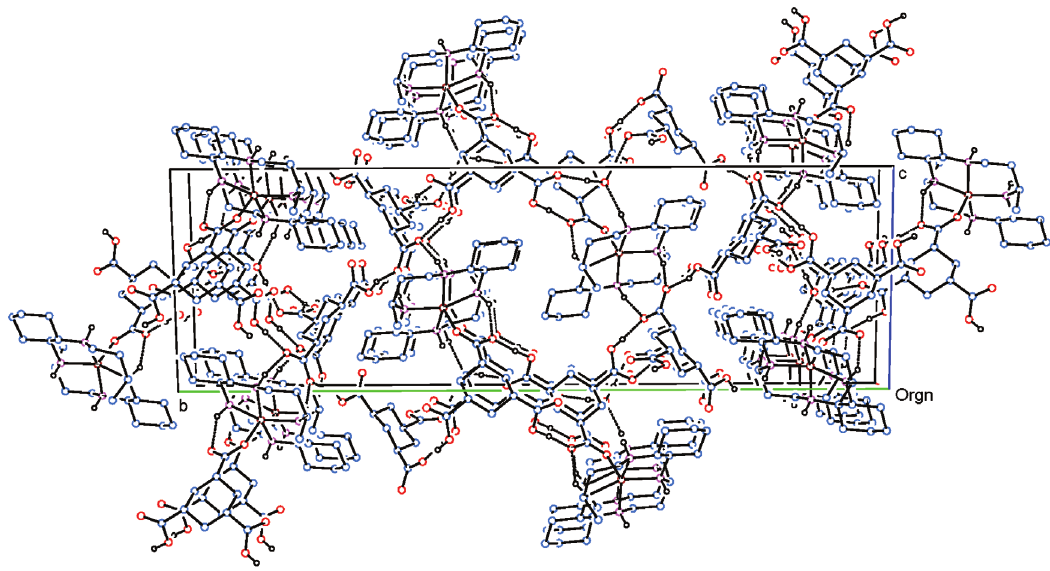
chtc - )]H chtc - ·H O ( 1 ). 2 2 2